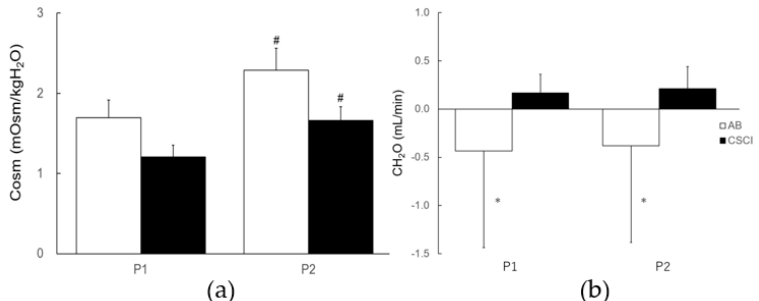
Figure 4. Cosm and CH2O at the two different time periods. Data are mean ± SEM. # p < 0.05 vs. P1, * p < 0.05 vs. CSCI. Abbreviations as in Figures 1 and 3. Cosm levels are shown in ( a ), and the levels of C H2O are shown in ( b ).